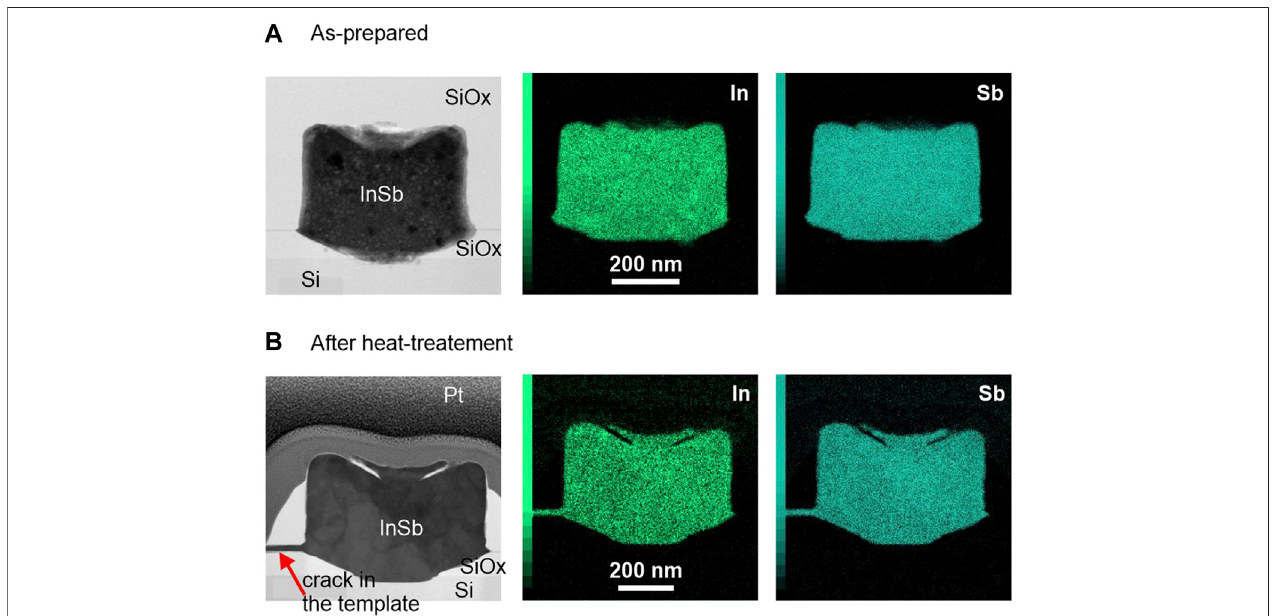
FIGURE 3 | (S)TEM images and EDX maps for (A) as-prepared and (B) annealed InSb deposits. The scale bar for all images is 200 nm.